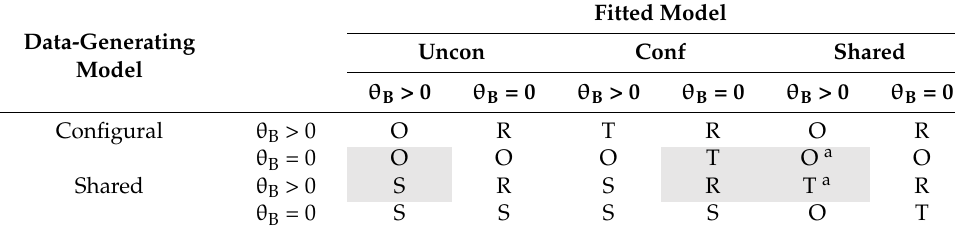
Table 2. Overview of the four data generation conditions (rows), and the six fitted models (columns).